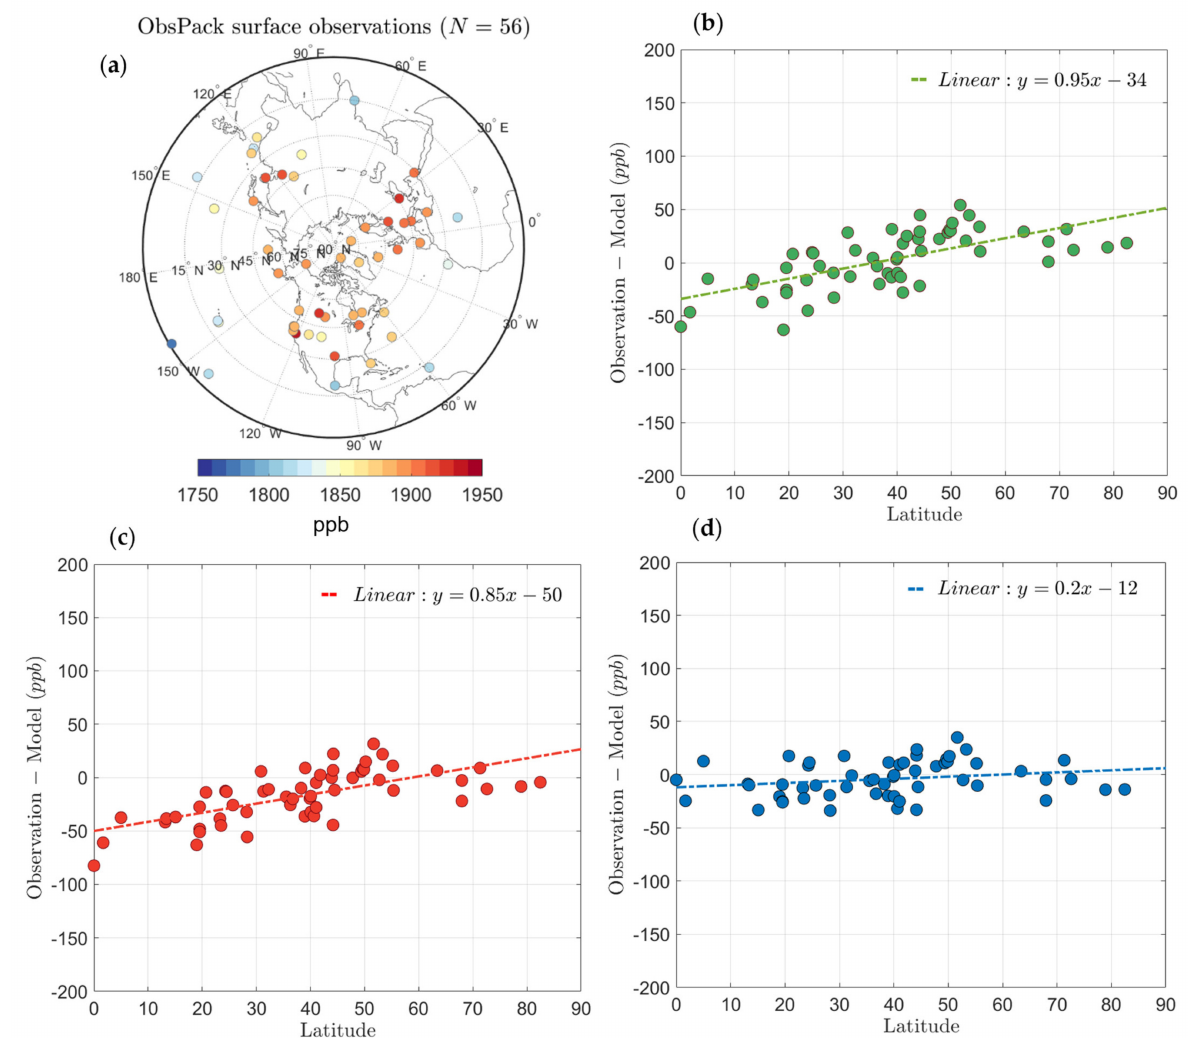
Figure 3. Difference between ( a ) methane surface observations (GLOBALVIEWplus surface flask and tower, shown top left) and model equivalent values of concentration for ( b ) the initial guess (green dots/line), ( c ) rescaled initial to April 2010 but before bias correction (red dots/line), and ( d ) after bias correction (blue